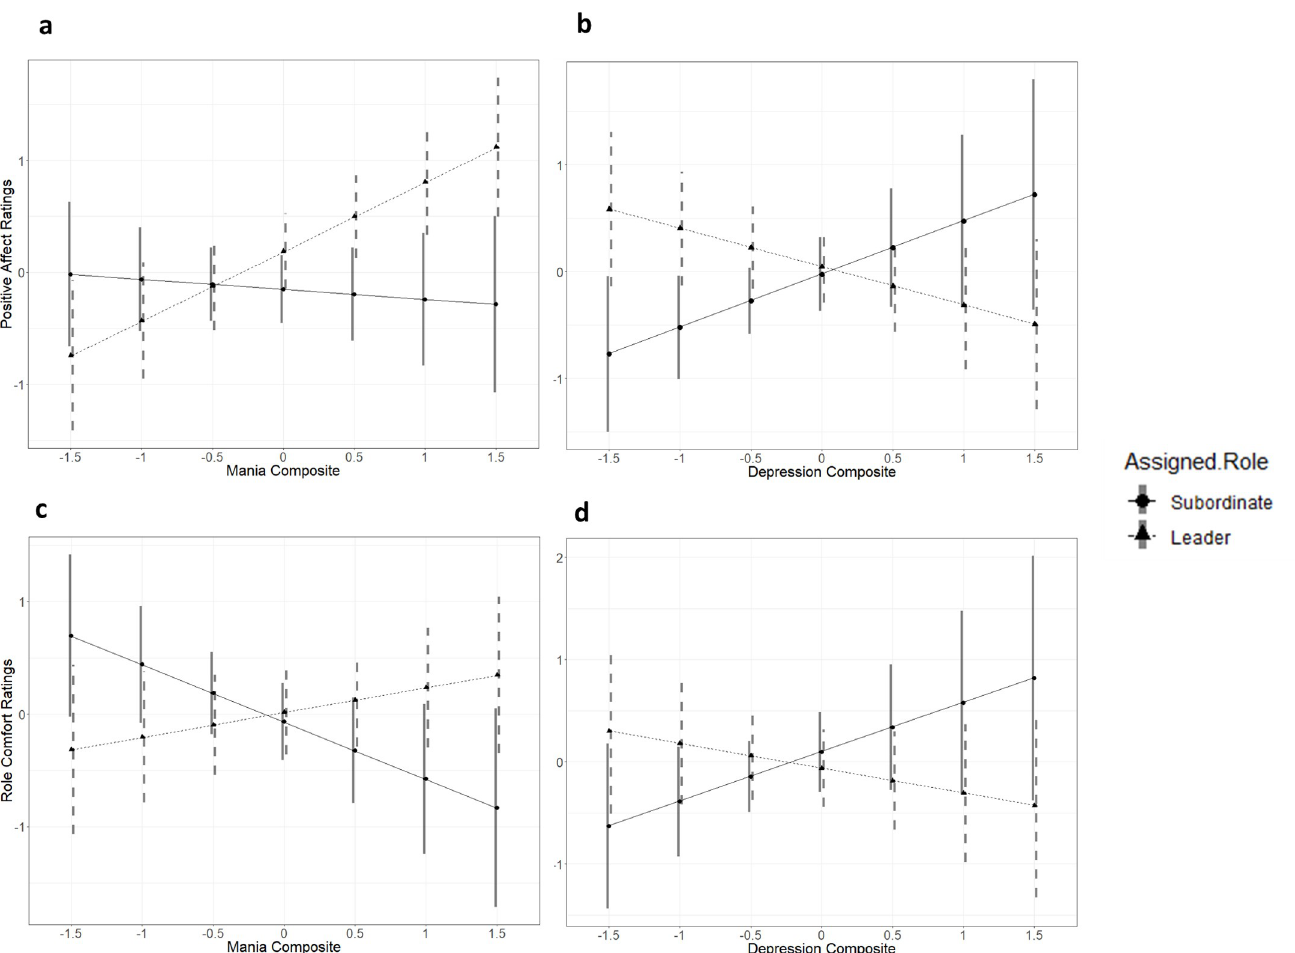
Fig 2. Interactions of assigned role with mania risk and depressive symptoms predict post-task positive affect, controlling for pre-task positive affect, and self-reported role comfort.